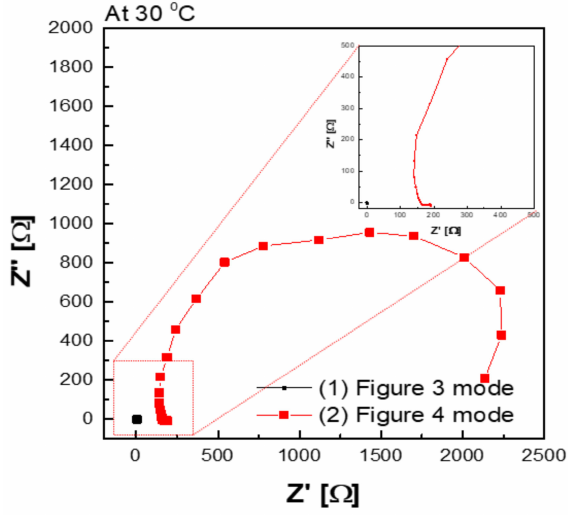
Figure 9. Hydroxide ion conductivity measured using the 4-probe method in 30 wt.% KOH solution immersing under 30 wt.% KOH condition.